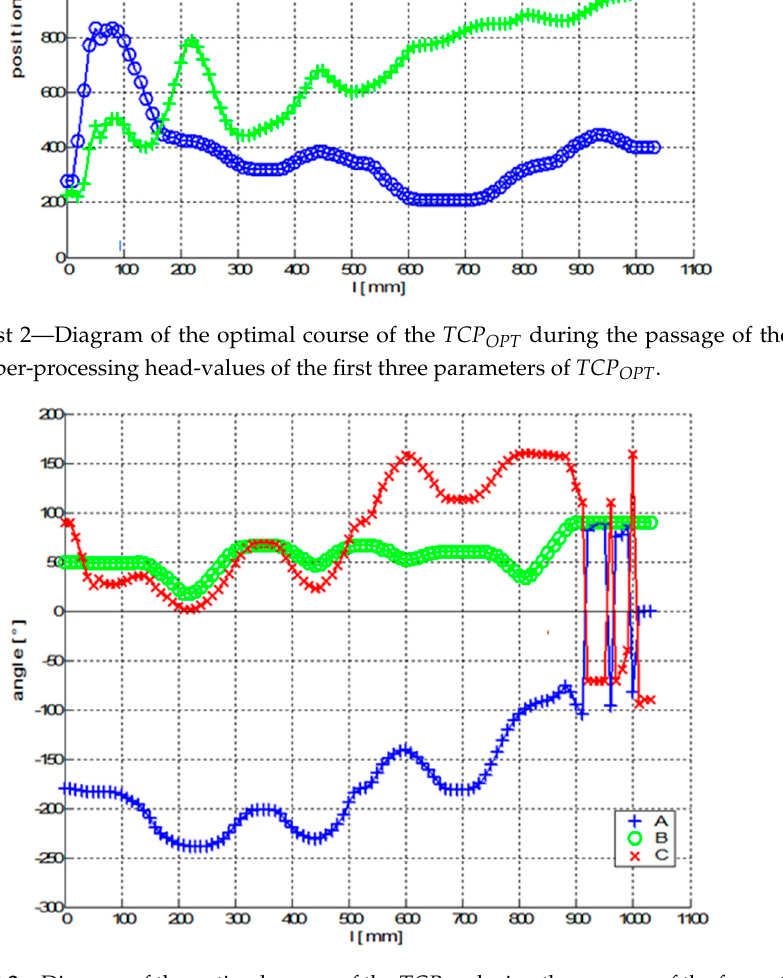
Figure 25. Test 2—Diagram of the optimal course of the TCP opt during the passage of the frame through the fiber-processing head—values of the last three parameters of TCP opt